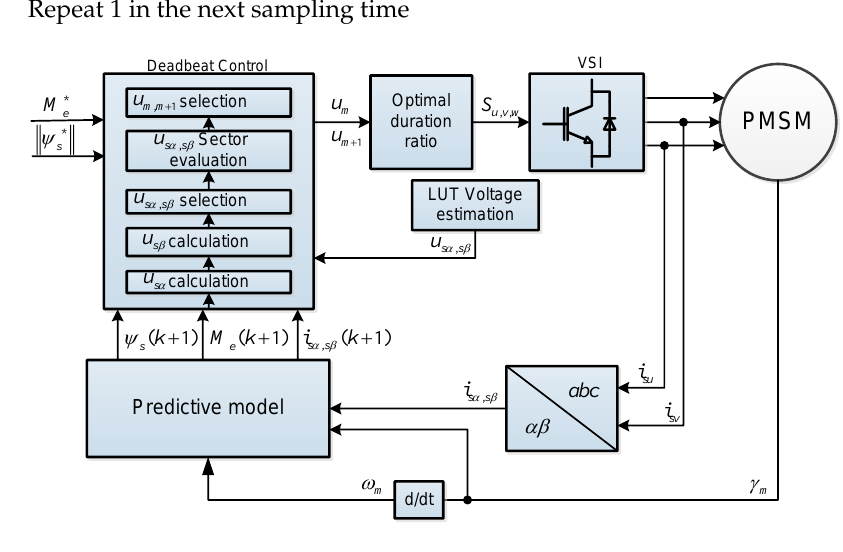
Figure 2. Simplified representation of the proposed control scheme.